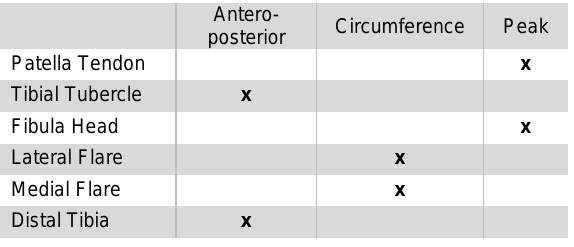
Table 1: Selection of measurements at